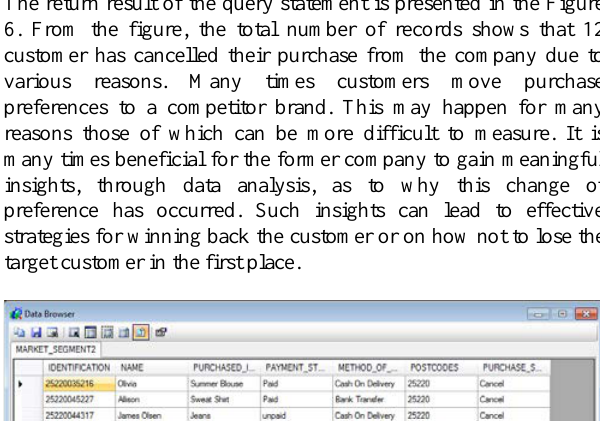
Figure 7. 3D buildings of 10,000 KM 2 urban area. Table 1. Comparison of overlap